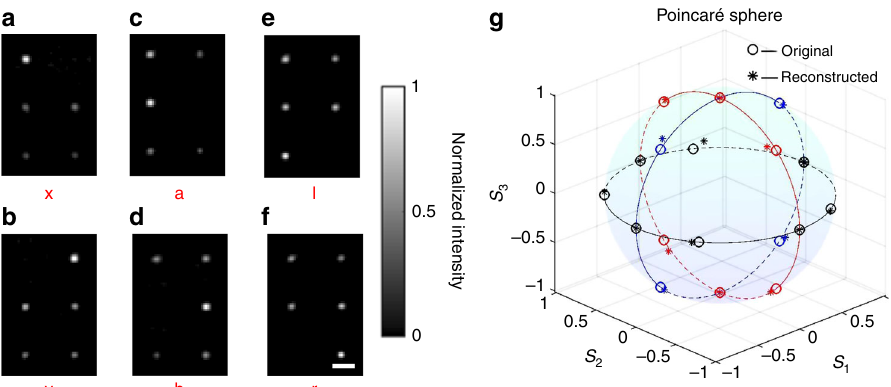
Fig. 3 Experimental validation of polarimetry with only one pixel of the metalens array. a – f Measured images of the resulting focal spots for incident horizontal or vertical linear polarization ( “ x ” and “ y ” ), diagonal linear polarization ( “ a ” and “ b ” ), and circular polarization ( “ l ” and “ r ” ). Scale bars: 10 μ m. g Poincaré sphere comparing the theoretical (small circles) and the experimentally reconstructed (stars) Stokes parameters s 1 , s 2 , and s 3 . For each of the three different colors (red, blue, black), one Stokes parameter is